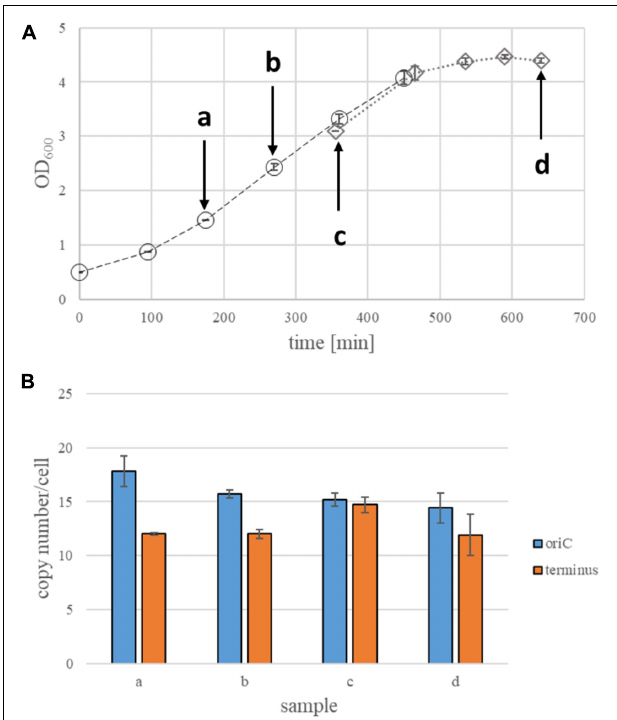
FIGURE 4 | Quantification of origin and terminus copy numbers in strain Zm4 under anaerobic conditions. (A) Growth curves of Zm4 strain under anaerobic conditions. Average OD 600 values of three biological replicates and their standard deviations are shown. Two sets of experiments (three biological replicates each) were performed, because in the first set of experiments the results in stationary phase did not meet the quality criteria (see different symbols and different dashed lines). Arrows indicate time points of collecting samples for quantification of genomic copy numbers. (B) Origin and termini copy numbers in anaerobically growing Zm4. Samples at an early stationary phase were collected about 1 h after the culture reached a plateau of its growth curve. All time points at growth phase are three biological replicates, while two biological replicates at an early stationary phase and 5 biological replicates were made for a late stationary phase. Standard deviations (STD) are presented as error bars.